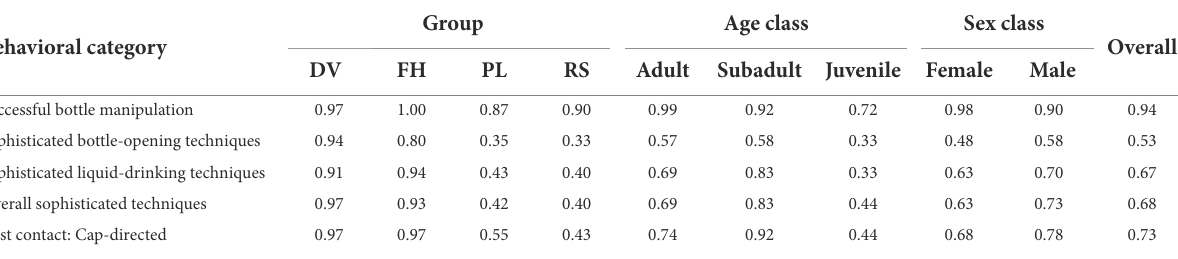
TABLE 5 Proportion of successful bottle-manipulation events and sophisticated techniques within different bottle-directed behavioral categories, displayed by different age-sex classes in the four study bonnet macaque groups during Task I.